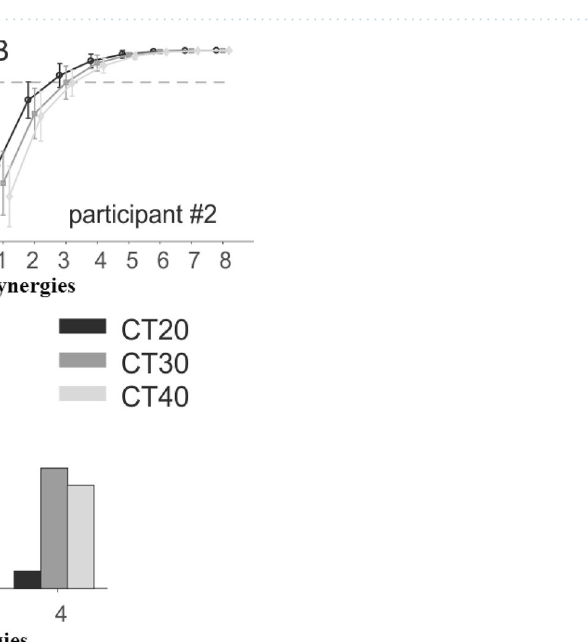
Figure 4. Moment cost function. Mean (± SD) of the total moment cost function (bold line: TotMCF , i.e., the sum of the MCF of participant #1 and #2), mean MCF of participant #1 (holding the load with the right hand, dashed line), and mean MCF of participant #2 (holding the load with the left hand, dotted line) ( A ) . Difference between the MCF of participant #1 and #2 (ΔMCF) ( B ) . The MCF corresponds to the sum of the joint moments applied to the arms, and is averaged over all gait cycles. For the same metric, the bars bearing different letters represent significantly different values (GLMM followed by a post-hoc test for multiple comparisons across conditions).